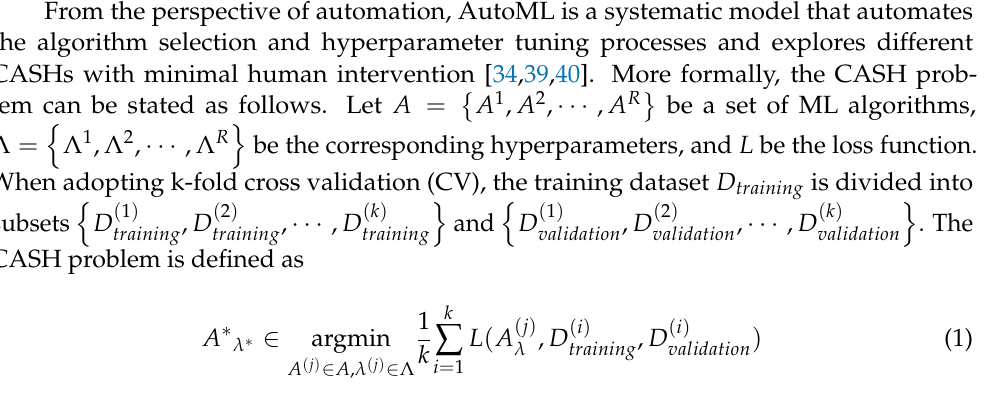
Figure 3. 3D PCA score plot of the input